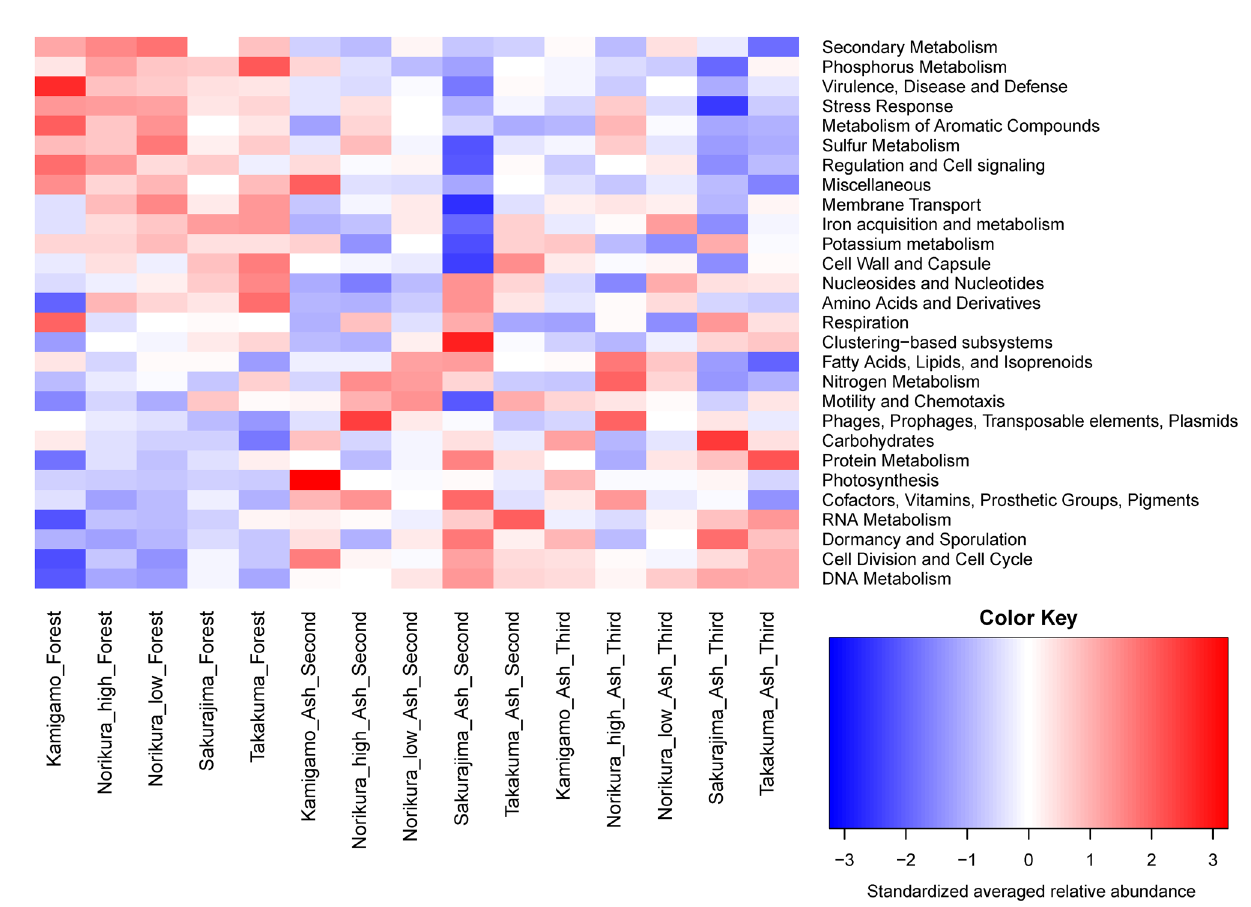
Figure 4. Heatmap of standardized averaged relative abundance of Level 1 functional gene